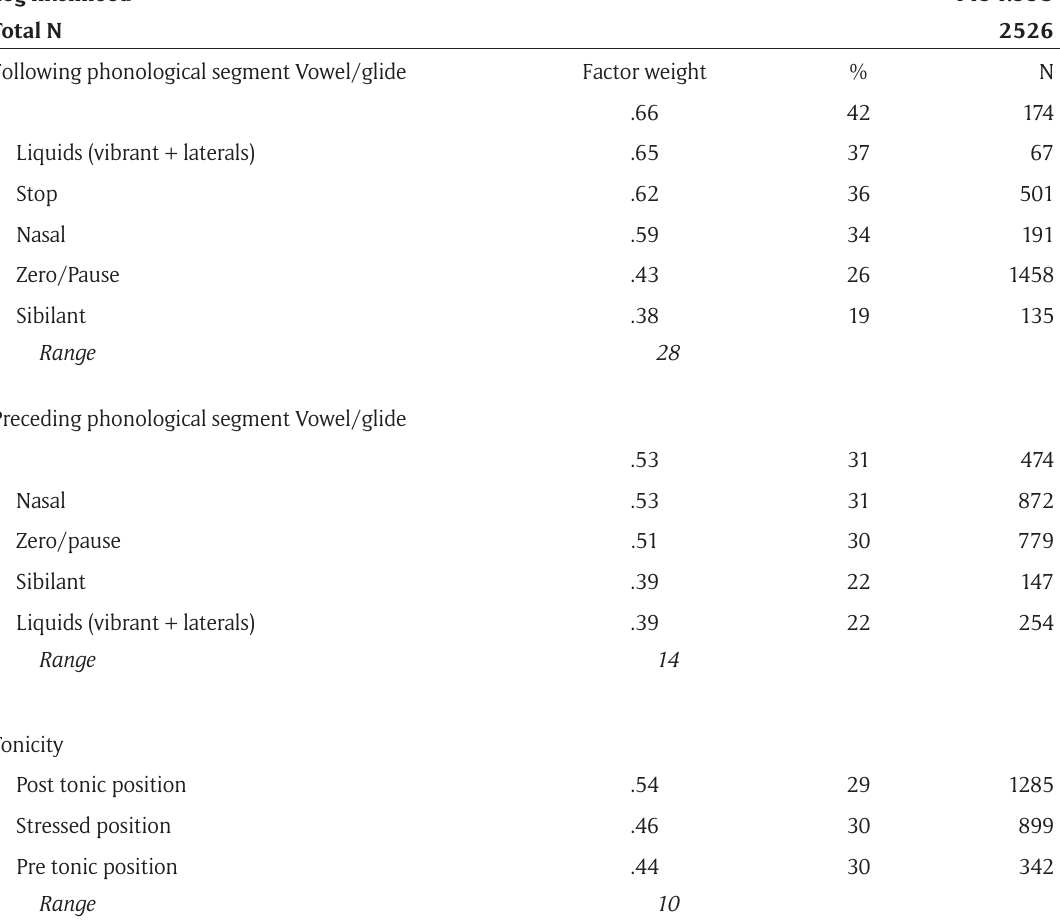
Table 10: Variable rule analyses of the contribution of linguistic factors selected as significant to the prob- ability of palatalization of /ti/, /di/ in UP (2007 data). Note : All factor groups selected as statistically